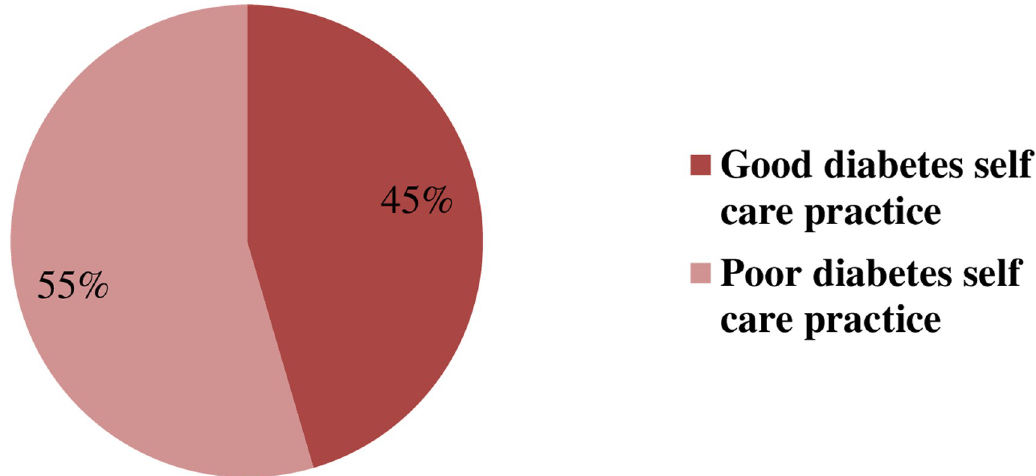
Fig 1. Showing diabetes self-care practice of patients with diabetes in Jimma University medical center, Ethiopia April 12-May 25 2020 (n = 343).